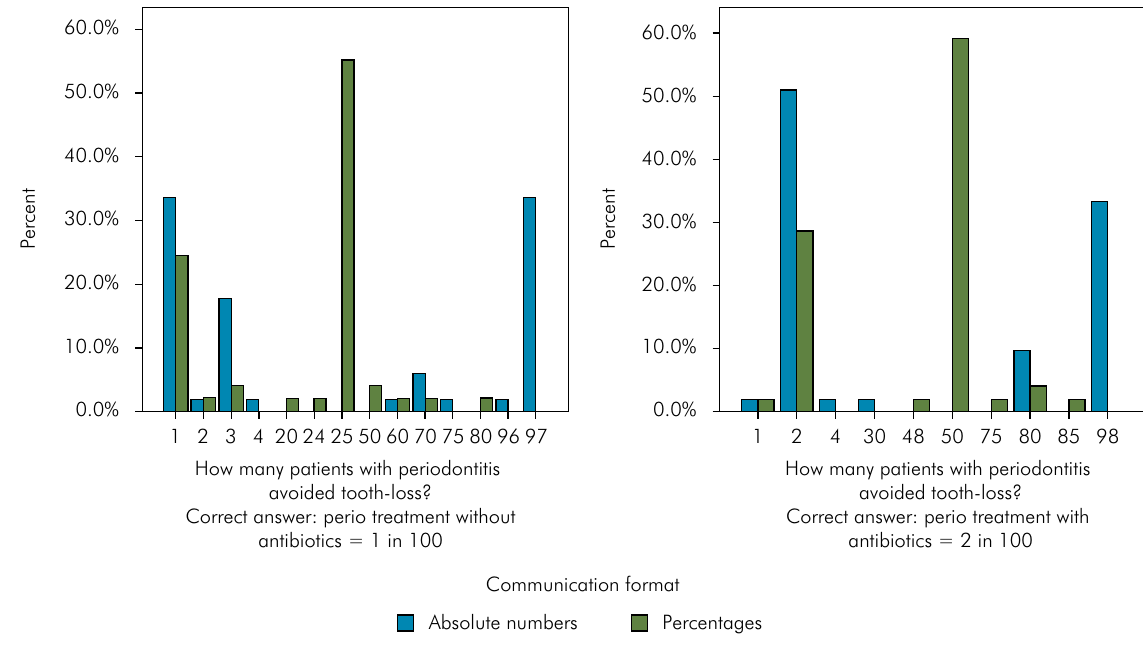
Figure 4. Frequency distribution of the answers given by the dentists to the question of how many patients will avoid multiple tooth losses due to the non-surgical periodontal treatment without (A) or with antibiotics (B). The right answer to non-surgical periodontal treatment without antibiotics is one and with antibiotics is two. Horizontal axis shows the answers given by the dentists. The bars show the percentages of each answer. Blue bars represent dentists in the natural frequencies’ group and green bars represent dentists in the percentages’